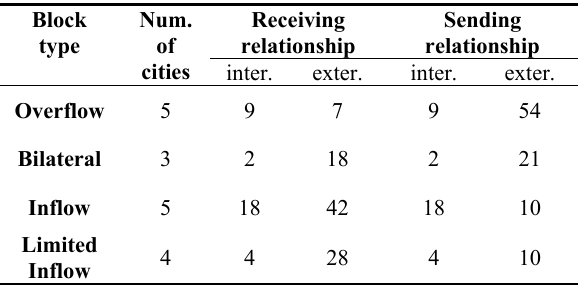
Figure 3. Variation characteristics of PM concentration in Hubei from 2018/3/1 to 2019/2/28: (a) average PM 2.5 concentration; (b) average PM 10 concentration; (c) frequency of extreme PM 2.5 pollution (defined as PM 2.5 ≥ 115 μ g/m 3 ); (d) frequency of extreme PM 10 pollution (defined as PM 10 ≥ 250 μ g/m 3 ). Figure 4. City role determination in regional PM 2.5 pollution: (a) Table 3. The results of PM 2.5 in winter Granger causual topology of spillover effects in each city; (b) block type network centrality degree. classification. In subplot (a), the abbreviation of ES, EZ, HG, HS, JM, JZ, QJ, SNJ, SY, SZ, TM, WH, XY, XN, XT, XG, YC represents Enshi, Ezhou, Huanggang, Huangshi, Jingmen, respectively; the color represents the number of relationships established in the corresponding city and the arrow represents relationship among cities. In subplot (b), the arrow represents wind vector. Table 4. Statistics of spatial relationships in PM 2.5 spillover